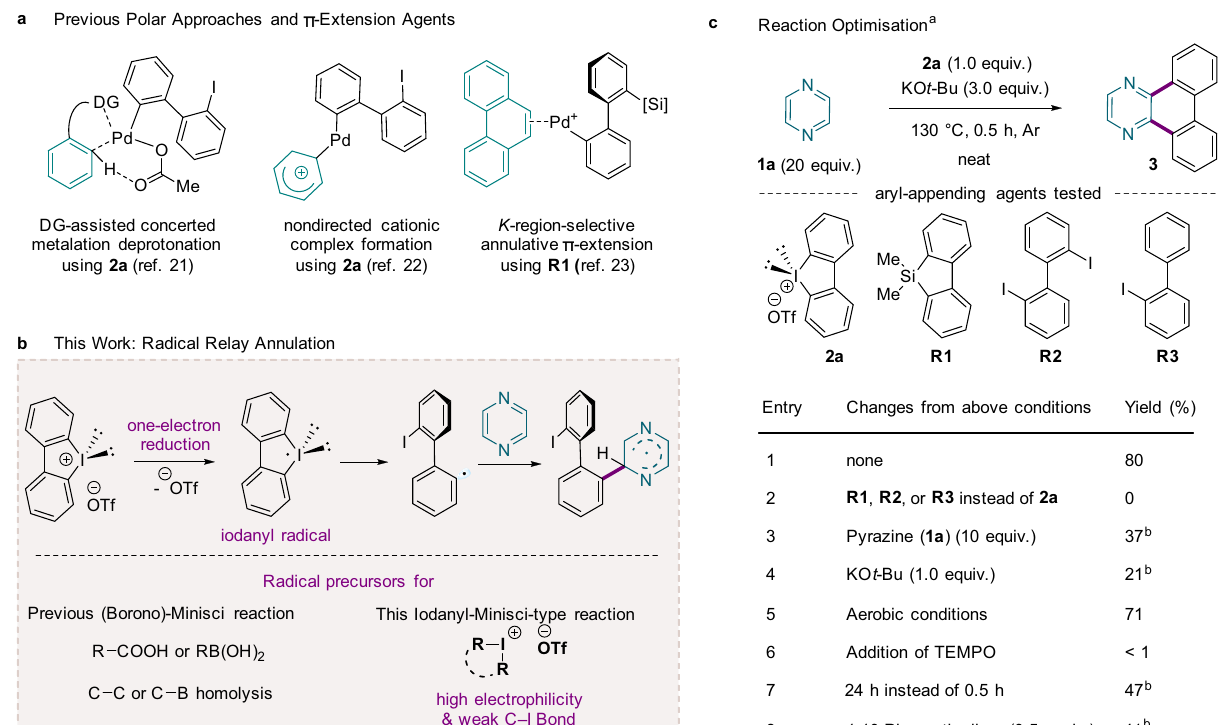
Fig. 2 Polar versus radical annulation approaches. a Transition-metal-catalysed polar annulation approaches. b Transition-metal-free radical relay annulation approach, wherein an in situ generated iodanyl radical directly activates a C – H bond of an unactivated azine. c Reaction optimisation. a Standard reaction conditions: 1a (4.0 mmol, 20 equiv.), 2a (0.20 mmol, 1.0 equiv.), KO t -Bu (0.60 mmol, 3.0 equiv.) at 130 °C under Ar for 0.5 h. Isolated yields. b GC yields using n -dodecane as an internal standard. DG directing group; − OTf tri fl ate (CF 3 SO 3 − ); KO t -Bu potassium tert